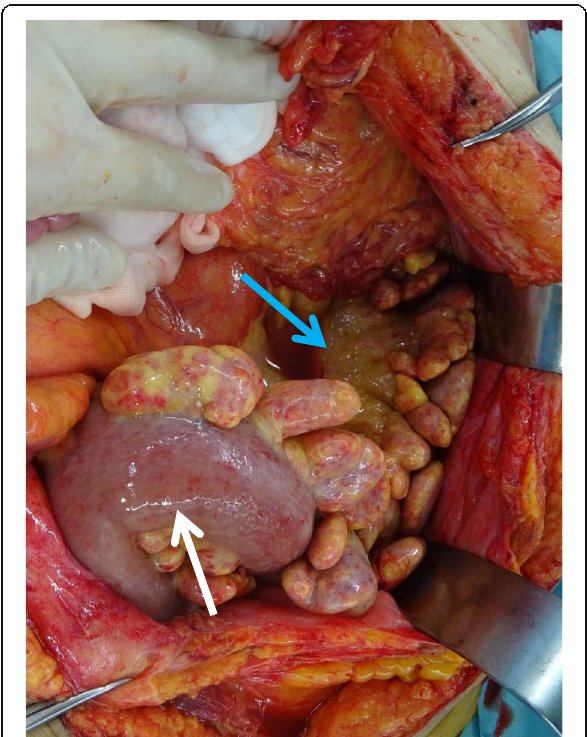
Fig. 4 At the first surgery, the sigmoid colon (white arrow) and mesentery (blue arrow) were too rigid and edematous to